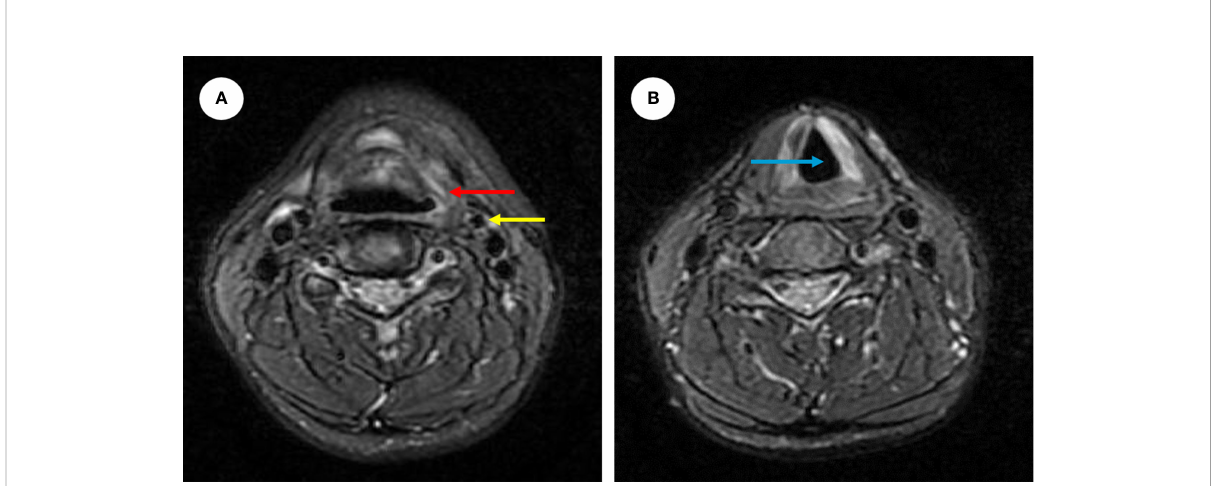
FIGURE 4 Enhanced MR images showing no tumor recurrence in the precarotid (yellow arrow) and preepiglottic spaces (red arrow) (A) and the normal anatomy of the laryngeal cavity (blue arrow) (B)